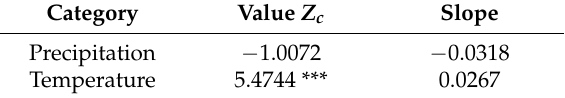
Table 1. Mann-Kendall test of temperature and precipitation change trends Category Value Z c Slope Precipitation − 1.0072 − 0.0318 Temperature 5.4744 *** 0.0267